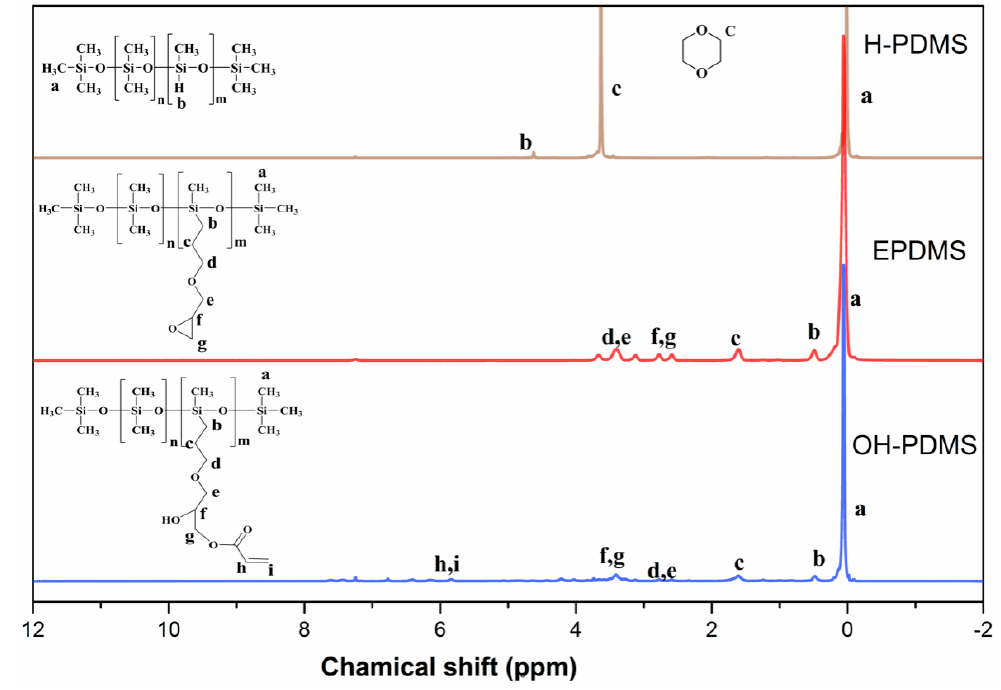
Figure 3. Proton nuclear magnetic resonance ( 1 H-NMR) spectra of H-PDMS, OH-PDMS, and EPDMS.